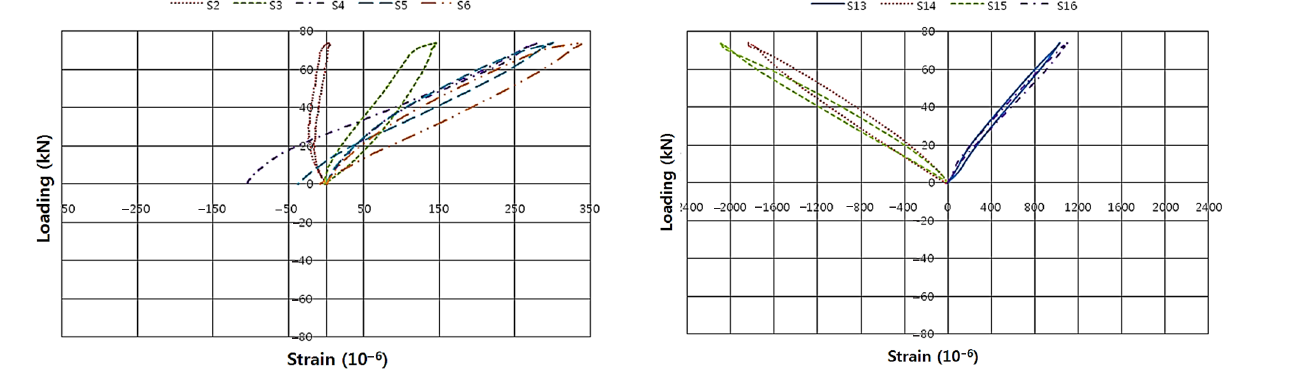
Fig. 13. Strain curves of X-braced rebar of PC beam under an eccentric load of 73 kN